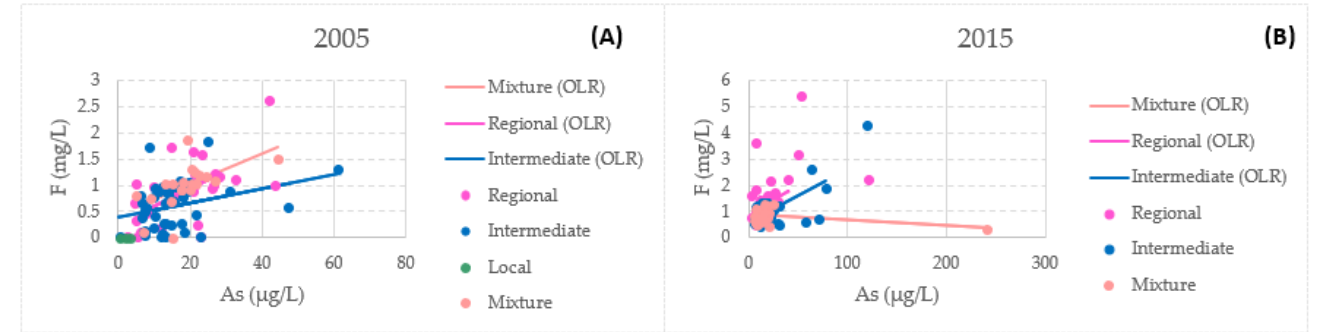
Figure 13. Uncertainty weighted least-squares linear regression (arsenic and fluor) for the different flow systems: ( A ) 2005 and ( B ) 2015.